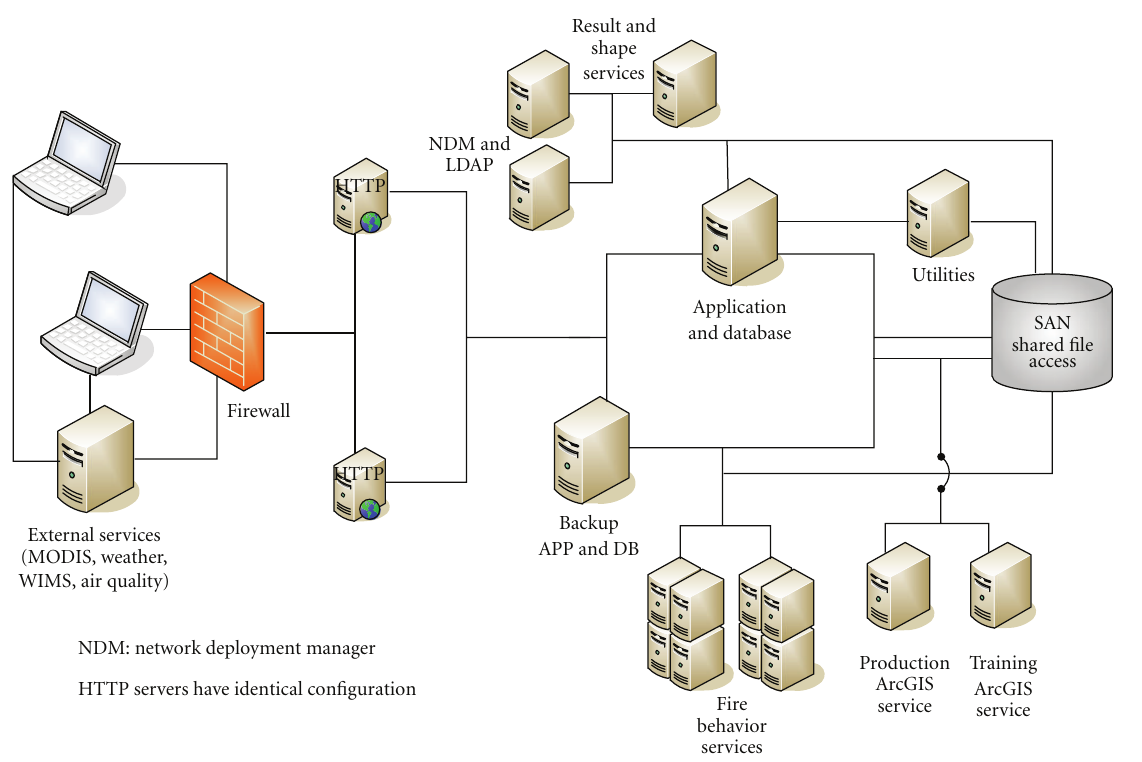
Figure 4: WFDSS technical architecture diagram for the production and training systems.